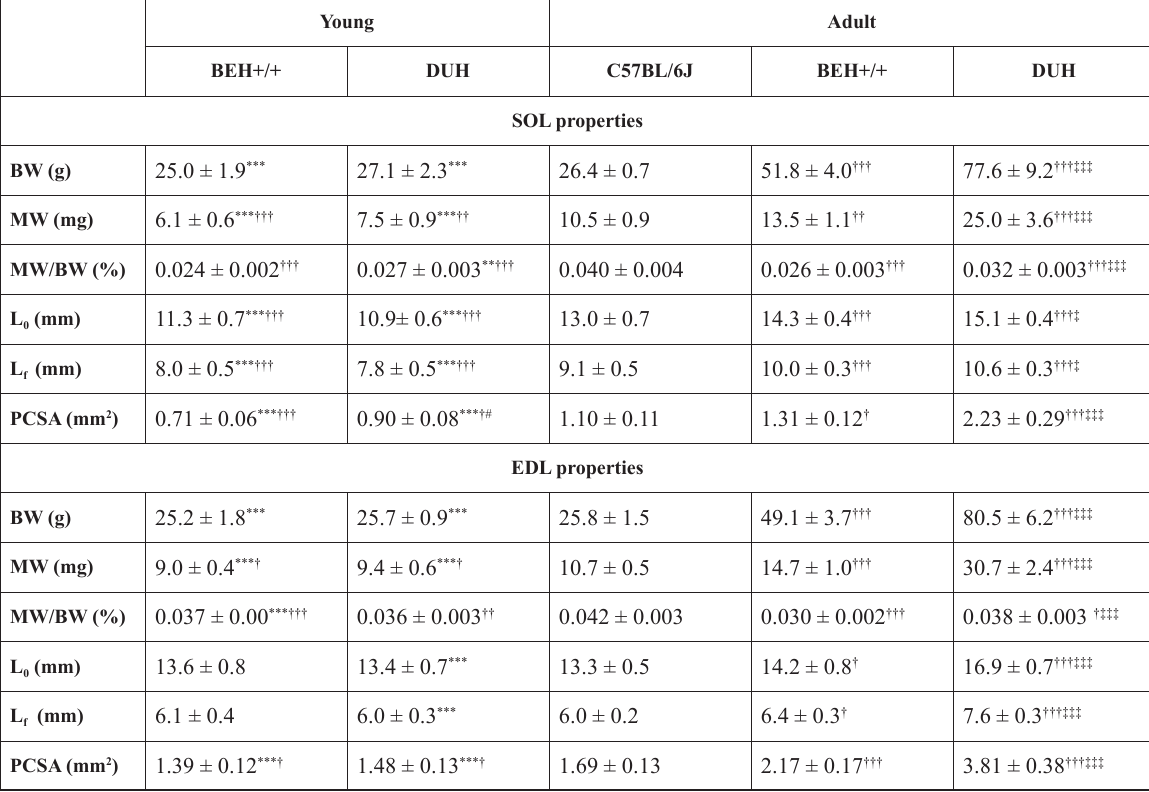
Table. Morphometric properties of soleus (SOL) and extensor digitorum longus (EDL) muscle in C57BL/6J, BEH+/+ and DUH strains of